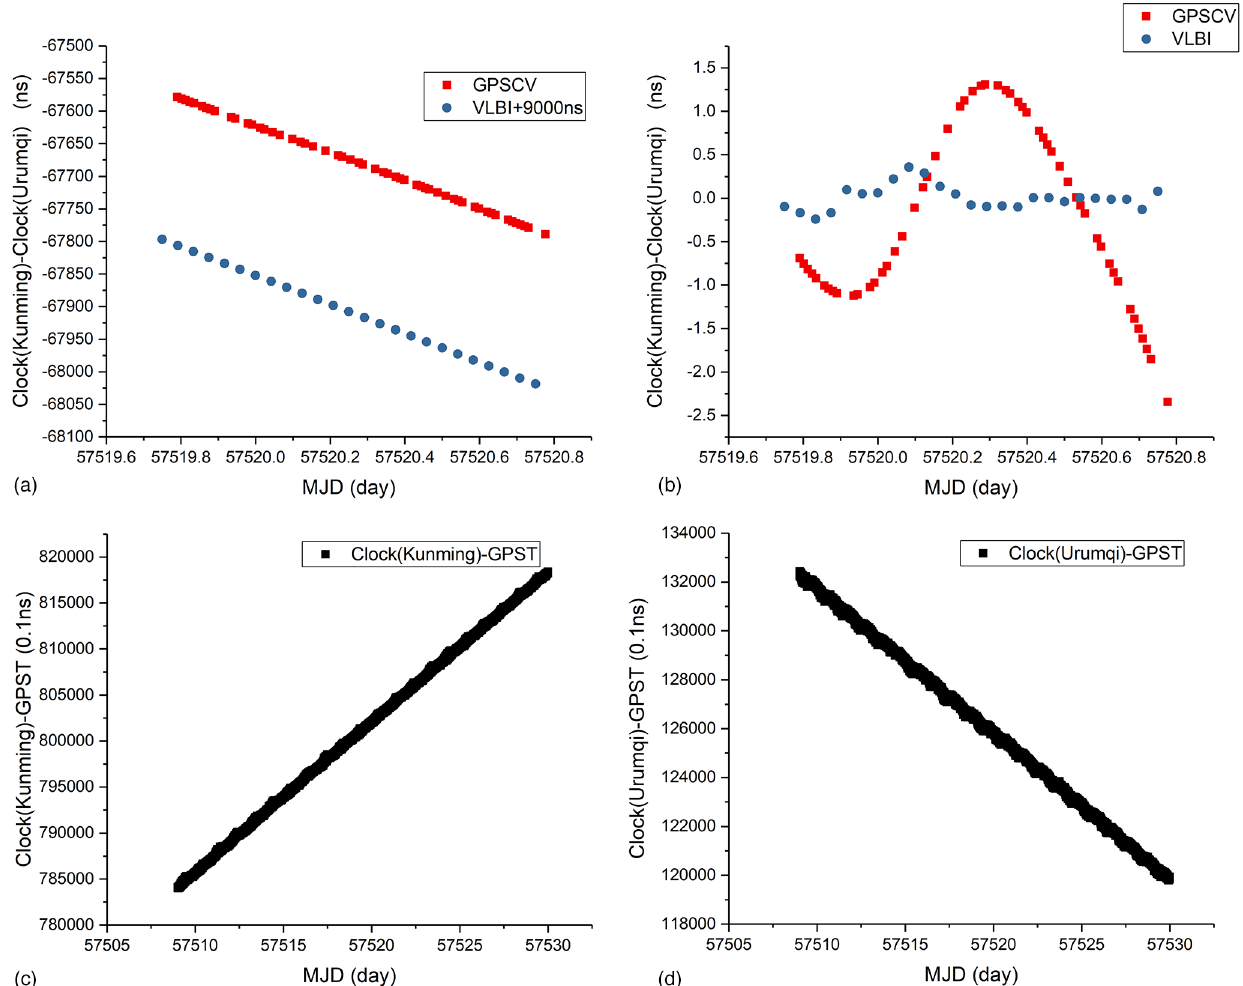
Fig. 6. Clock differences at the Kunming and Urumqi stations in MJD57519. (a) Clock differences calculations based on GPS CV and VLBI respectively. (b) Clock difference series after removing the linear trend. (c) Clock difference series between the Kunming station clock and GPST across 20 days surrounding MJD57519. (d) Clock difference series between the Urumqi station clock and GPST across 20 days surrounding